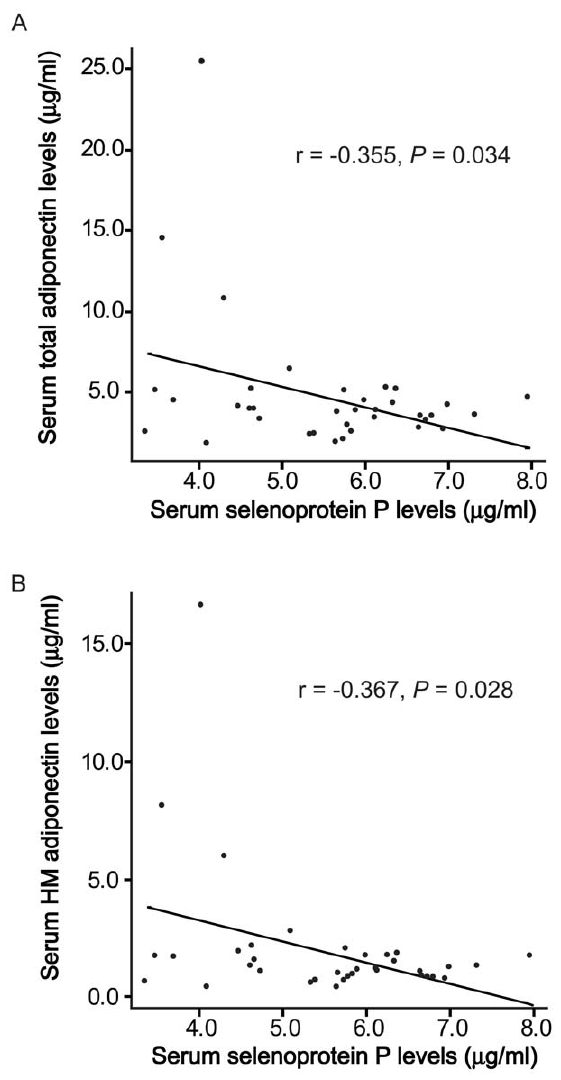
Figure 2. Correlation between serum levels of selenoprotein P and total adiponectin (A) and high-molecular adiponectin (B) in patients with type 2 diabetes. Pearson’s analysis r and P values are shown.